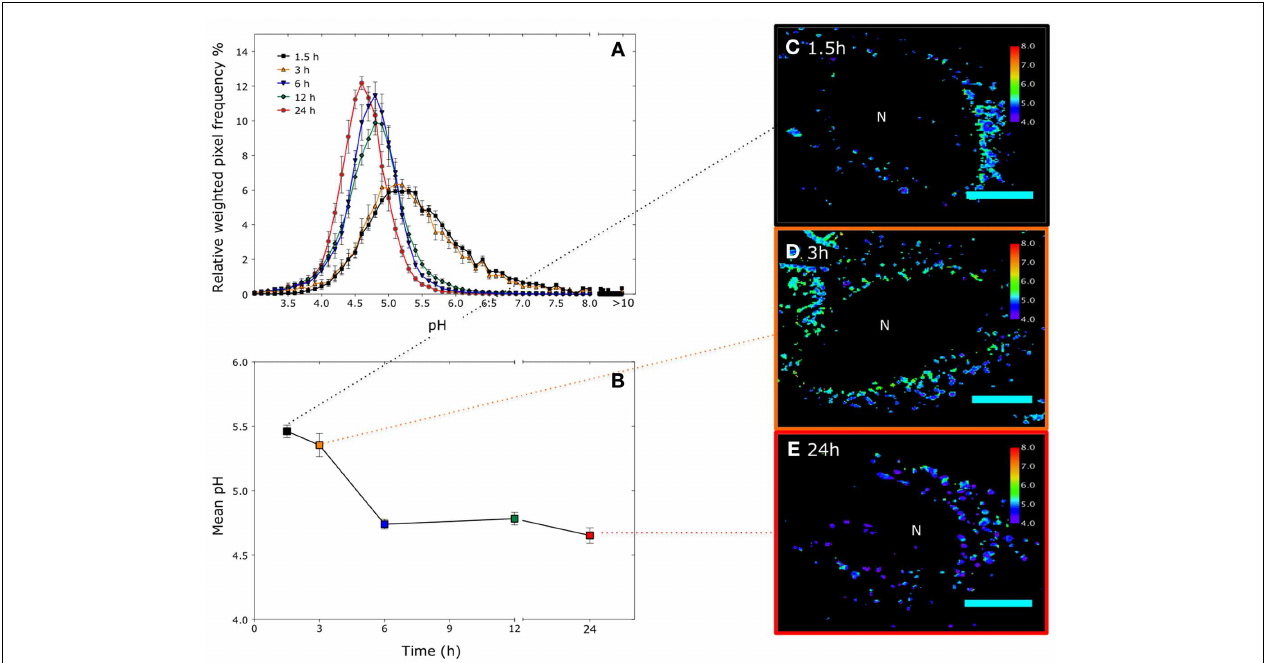
FIGURE 5 | Time resolved pH measurements in HeLa cells using a polyacrylamide nanosensors incorporating two pH-sensitive fluorophores and a reference fluorophore (5-(6)-carboxyfluorescein (FAM)/Oregon Green) and a reference fluorophore 5-(and-6)-carboxy- tetramethylrhodamine (TAMRA): (A) pH distribution in cells over different